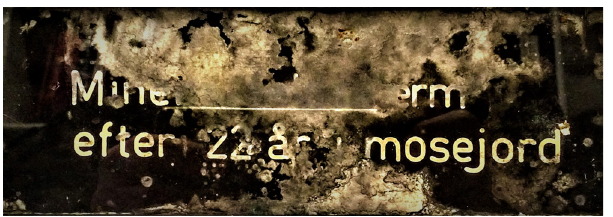
Figure 1: Partially dissolved cardboard sign. Translated from Danish to English, the text fragment reads: Mine ( ? ) [] [] erm ( ? ) after 22 years in ( ? ) peat soil . The author purchased the sign from its previous owner who found the sign clearing his deceased father ’ s garage. Original context, date and fi nd spot unknown; exact meaning of the sign unclear. Photograph by the author, Islands Brygge, Copenhagen. January 20,